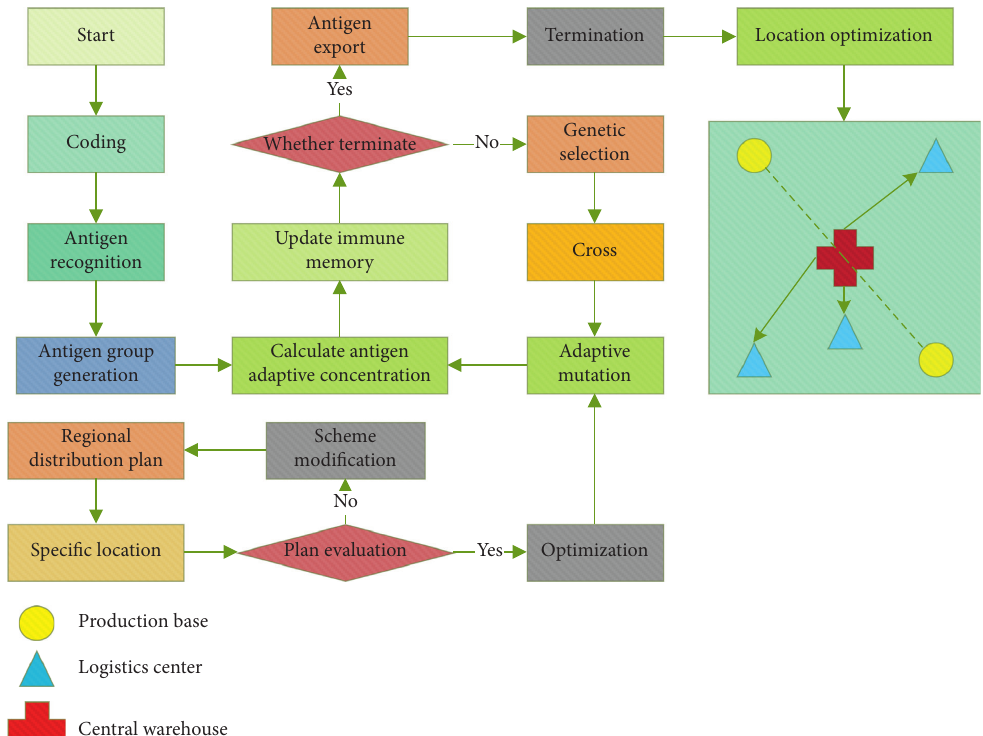
Figure 2: Genetic algorithm